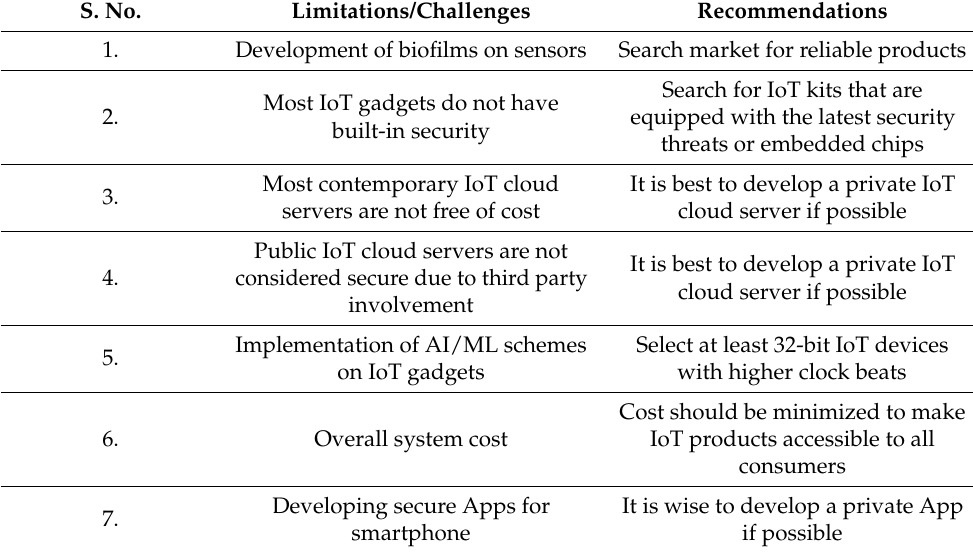
Table 6. Significant limitations and challenges of IoT-controlled water